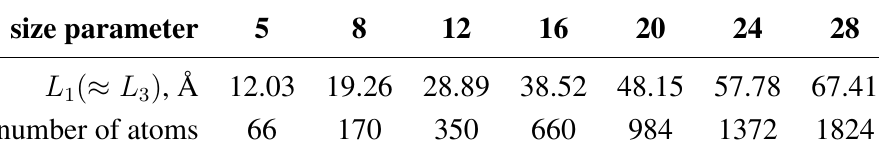
Table 1. The size of the graphene lattice samples used in the numerical examples. The size parameter is used in the plots, and this table specifies the physical dimensions of the numerical test